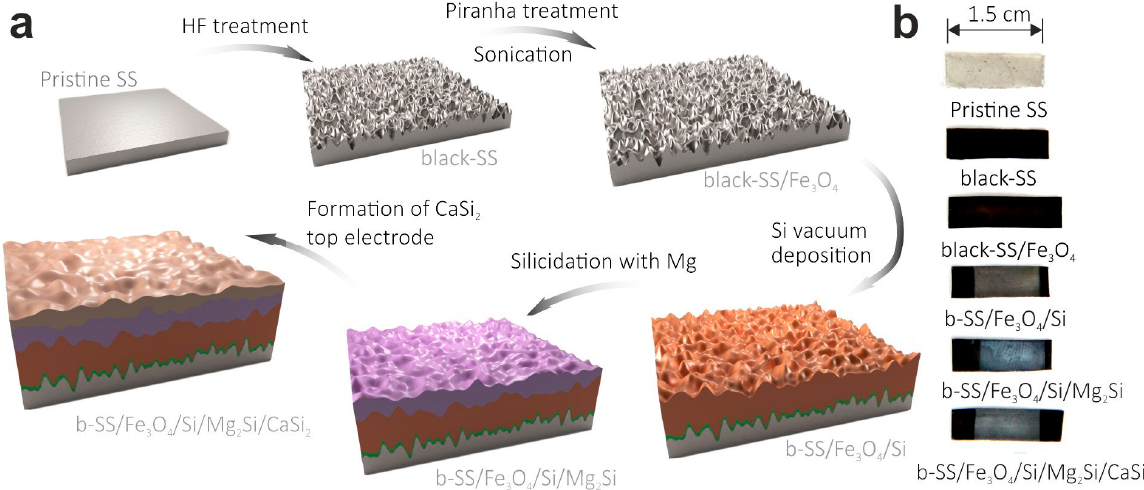
Figure 1. ( a ) Illustration of step-by-step fabrication of the black-Mg 2 Si/Si heterostructure with a top semimetal CaSi 2 transparent electrode grown on textured stainless steel substrate. ( b ) Photographs of corresponding SS samples at each fabrication step.